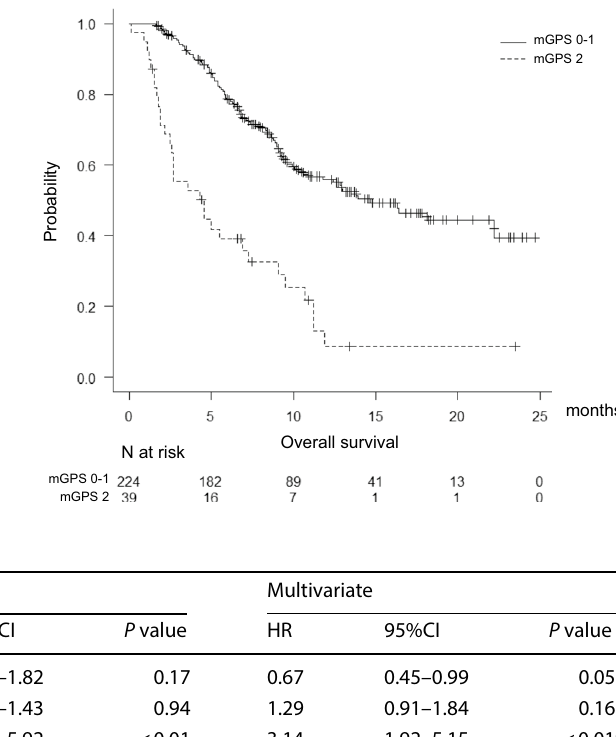
Fig. 1 Kaplan–Meier curves for overall survival (OS). There was a significant difference between the mGPS 0–1 and mGPS 2 groups